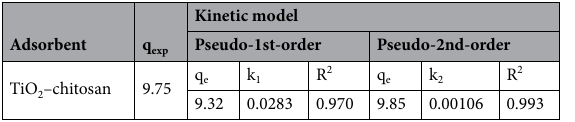
Table 4. Kinetic parameters of COD sorption using TiO 2 –chitosan adsorbent.